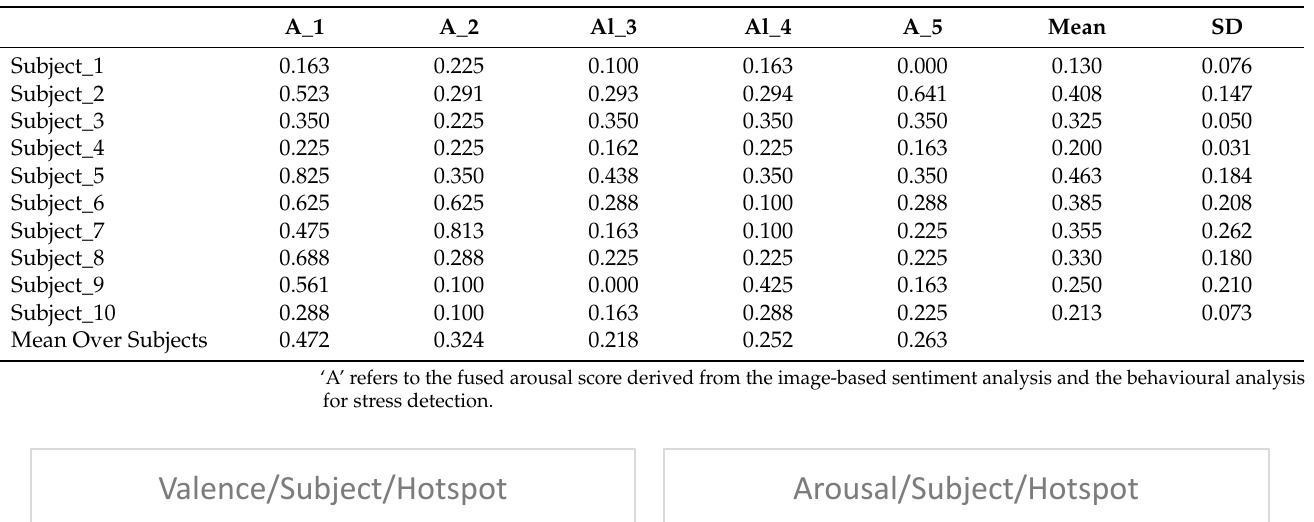
Table 2. Arousal scores per subject and per hotspot.